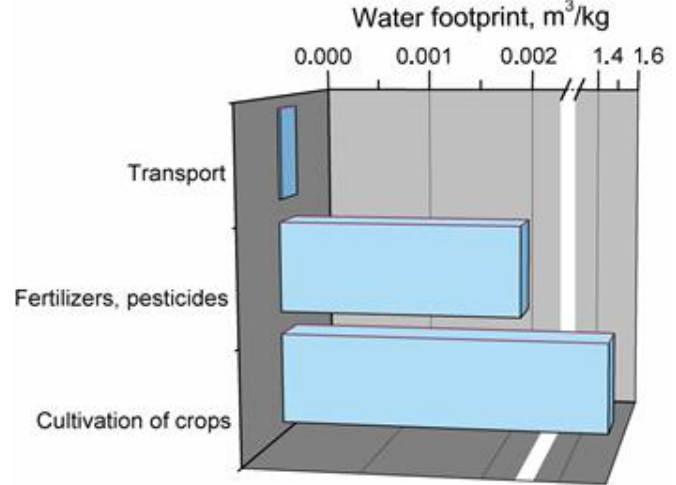
Figure 9. Main components of production system generating water footprint of jute fibers.